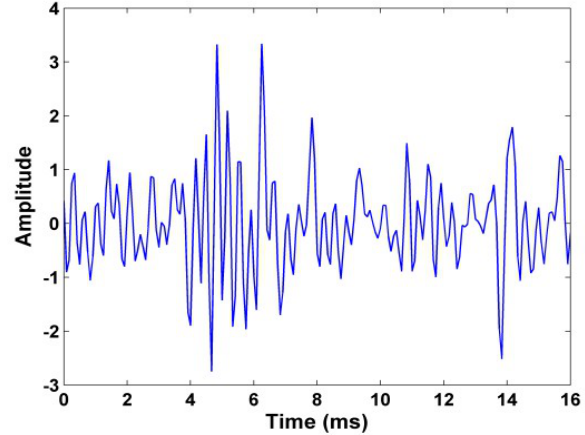
Figure 1. Time domain of an inner ring faulty bearing signal.